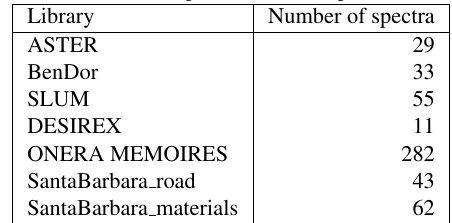
Table 1: Origin of collected